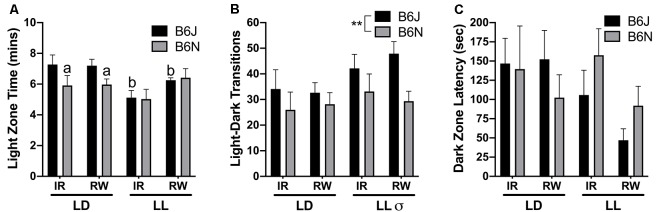
Light-dark box. (A) In LD but not LL, B6J mice exhibited increased light zone time compared to B6N, as indicated by the letter a. Light zone time is decreased in B6J/LL compared to B6J/LD, as indicated by the letter b. (B) Photoperiod (LD < LL) and strain (N < J) differences were observed for the number of transitions. (C) Dark Zone Latency is the time it takes for the mouse to make the first entry into the dark zone. No differences for dark zone latency were found among the groups. σLD vs. LL difference, **significantly different from each other at p < 0.01. a = B6N < B6J in LD, and b = B6J/LL < B6J/LD, at p < 0.05.